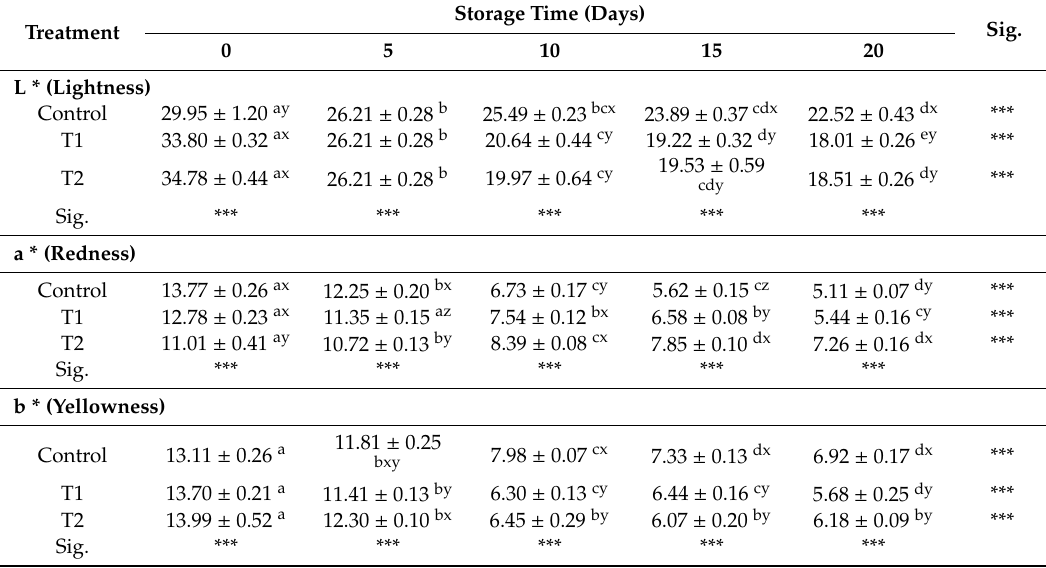
Table 5. E ff ect of Moringa flower on instrumental colour of chicken nuggets during the storage time (mean values ± error standard of six samples). Control = no additive; T1 = 1.0% Moringa flower extract; T2 = 2.0% Moringa flower